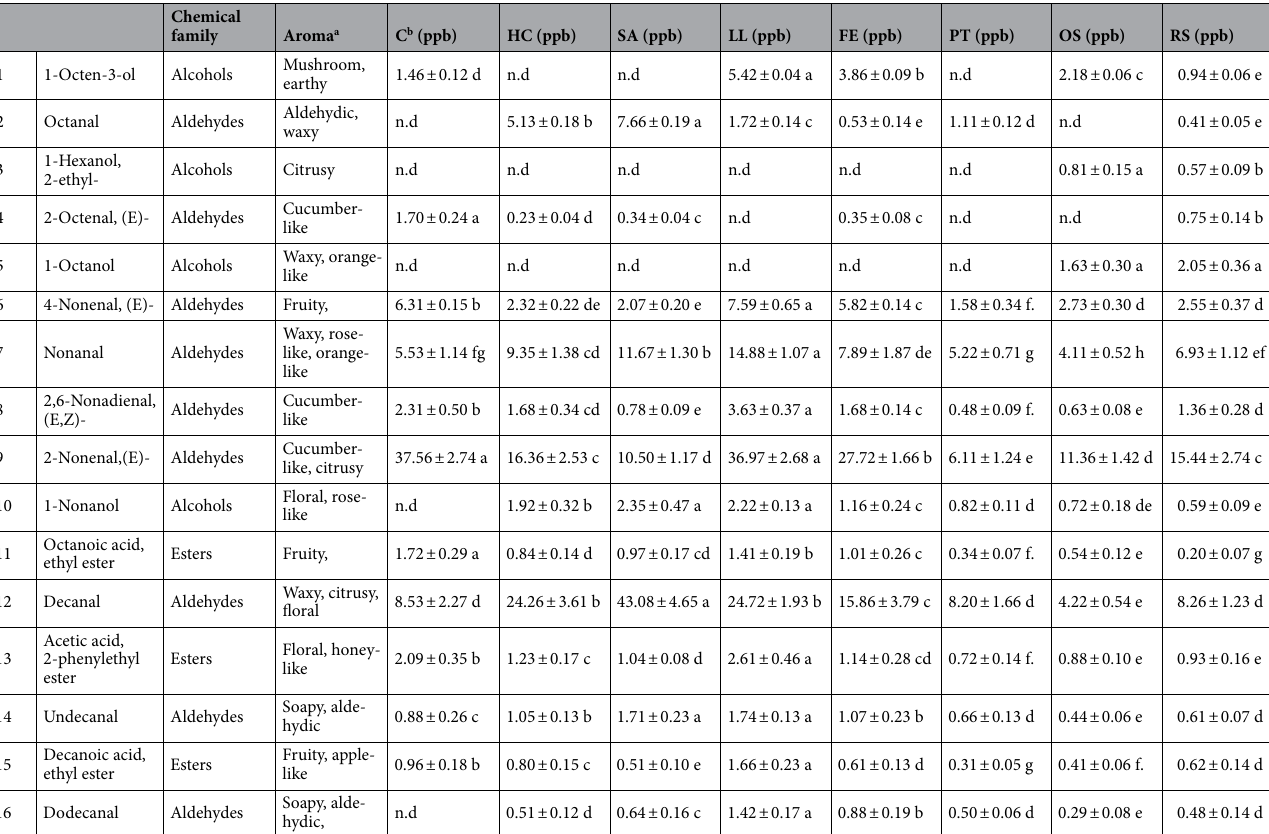
Table 2. Volatile compounds in winter wheat malts. a As decribed by Gao et al., McGorrin and Czerny et al. 13–15 . b Data are shown as means ± standard deviation (n = 3). Different letters indicate homogenous groups analysed with the Tukey test (α = 0.05). N.d not detected. Abbreviations are as follows: C malt produced from wheat grains grown without addition of seed meals or herbicides, HC malt produced from wheat grains grown without addition of seed meals, cultivated with herbicide treatment, FE malt produced from wheat grains grown with addition of seed meal from Fagopyrum esculentum Moench., SA malt produced from wheat grains grown with addition of seed meal from Sinapis alba L., PT malt produced from wheat grains grown with addition of seed meal from Phacelia tanacetifolia Benth., LL malt produced from wheat grains grown with addition of seed meal from Lupinus luteus L., RS malt produced from wheat grains grown with addition of seed meal from Raphanus sativus L. var oleiformis Pers., OS malt produced from wheat grains grown with addition of seed meal from Ornithopus sativus